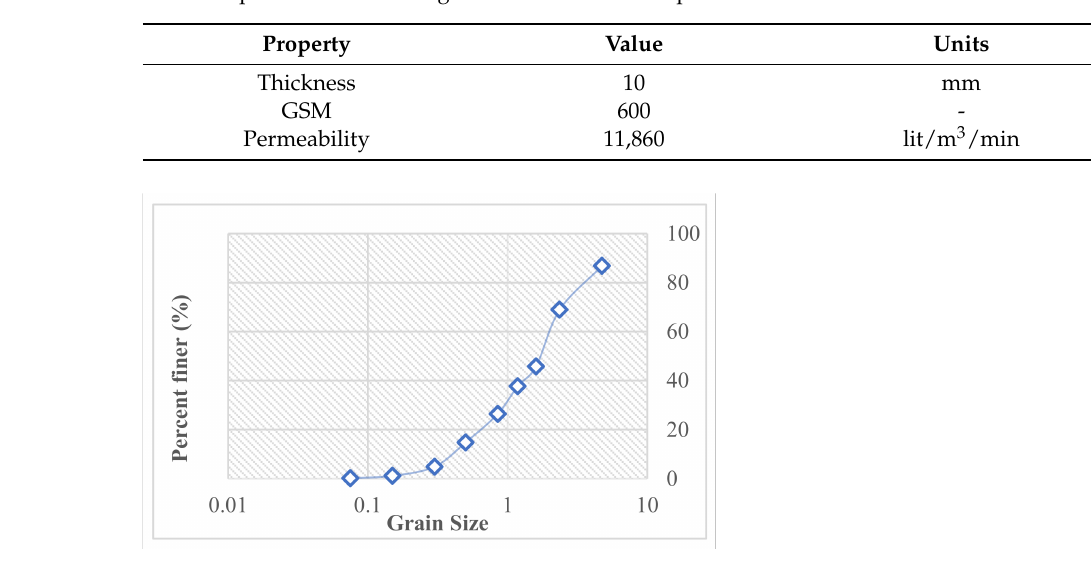
Figure 2. Grain size distribution of sand used in